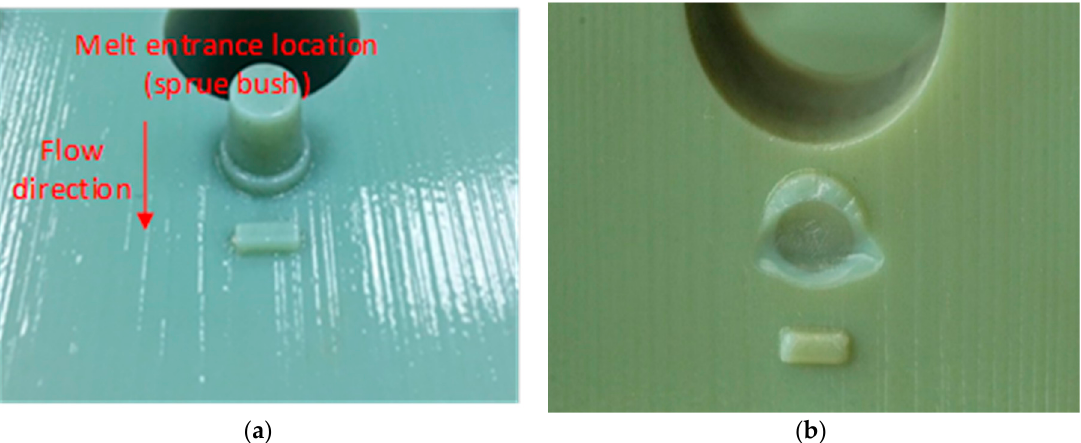
Figure 11. ( a ) Boss feature before molding. ( b ) Bending failure of the boss feature due to high injection pressure. See Figure 4 for the location on the tool.